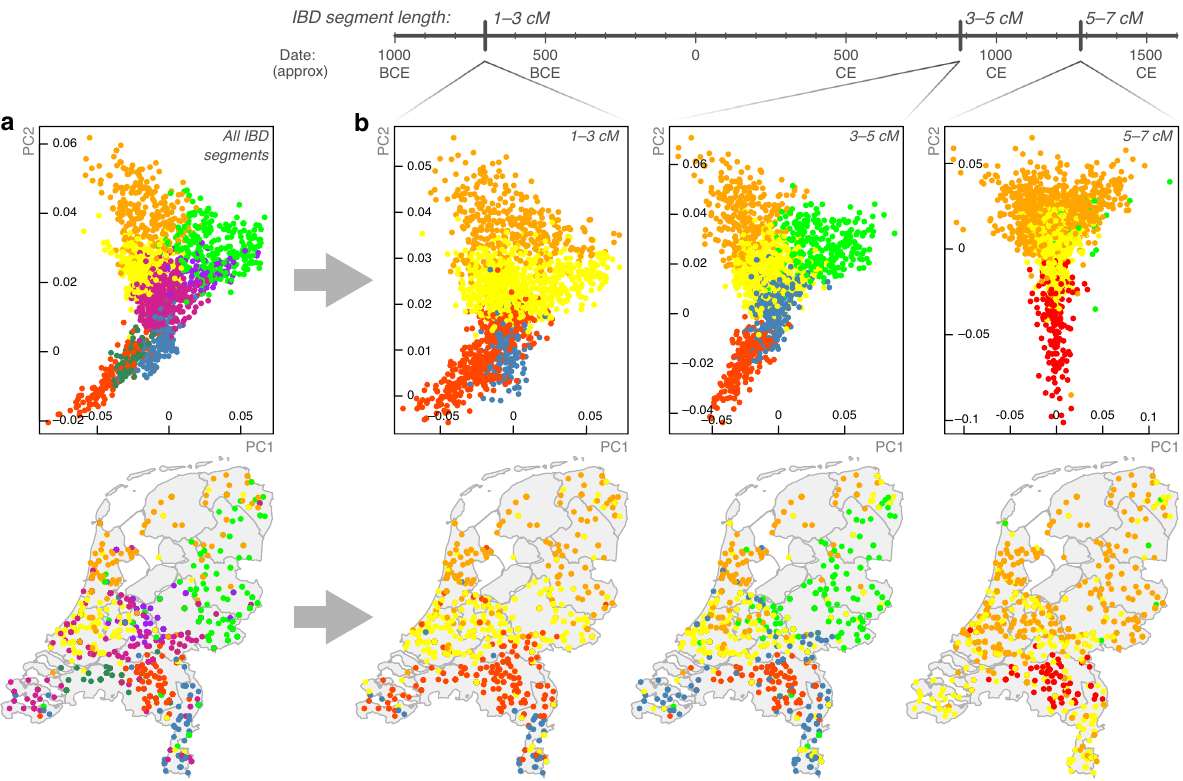
Fig. 3 The changing genomic structure of the Dutch population over time. a Principal component (PC) analysis of pairwise total identity-by-descent (IBD) for 1626 Dutch individuals (top) and their geographical provenance (bottom). Points represent individuals and are coloured by cluster assignment (mclust on pairwise IBD matrix). b PCs (top) and geographical provenance (bottom) for pairwise sharing of 1 – 3, 3 – 5 and 5 – 7 centiMorgan (cM) IBD segments, corresponding to point estimates of expected time depths at ~2700, 1120 and 720 years ago, respectively. Time depths for IBD segment bins have wide distributions 25 ; expected values presented here should be interpreted as a guide only and the changing west-east structure over time does not necessarily re fl ect (for instance) a precisely-timed admixture event. Map boundary data from the Database of Global Administrative Areas (GADM; https://gadm.org).